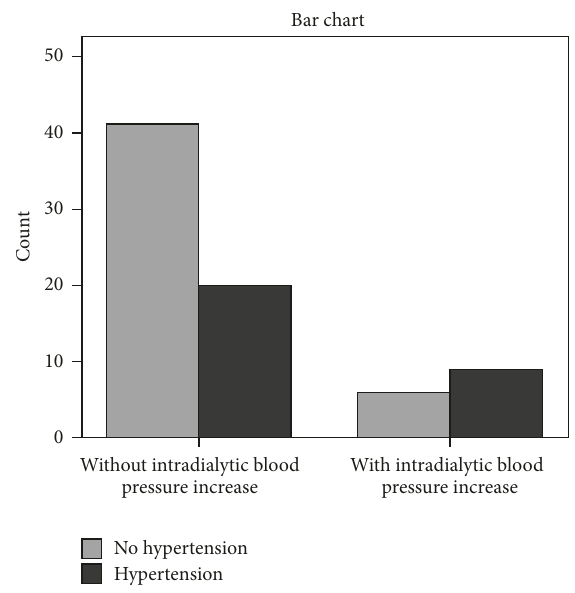
Figure 2: The prevalence of intradialytic hypertension in partici- pants with extradialytic hypertension ( 𝑥 2 = 4.2 , 𝑝 = 0.04 ). and dialyzability status were not significantly associated with intradialytic BP variability